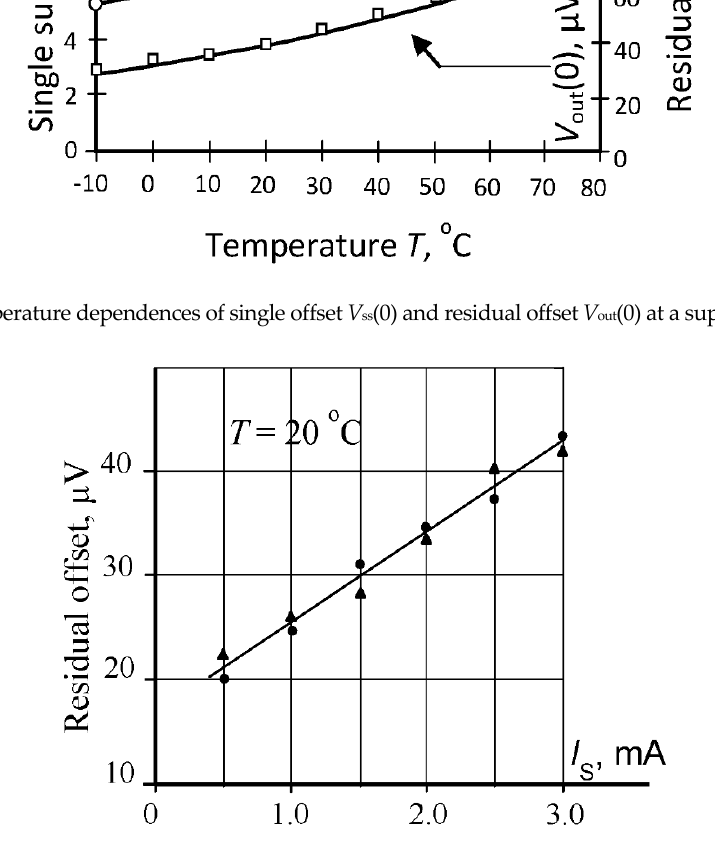
Figure 5. Residual offsets at field B = 0 ( ● ) and induction B = 0.35 T ( ▲